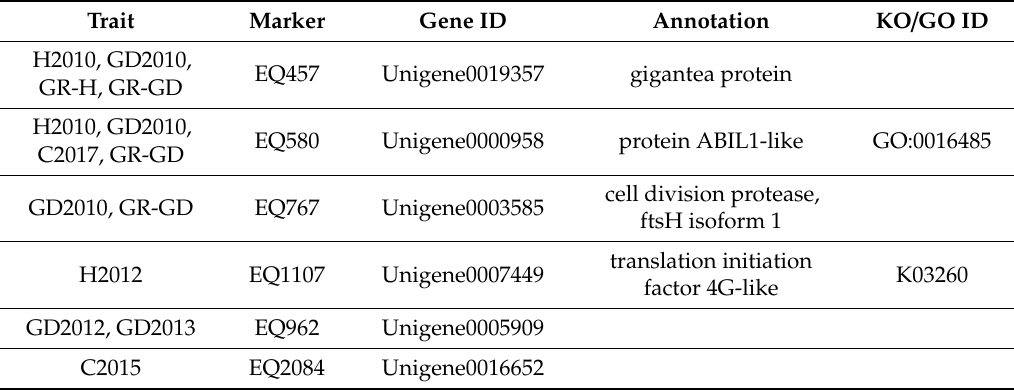
Table 5. Candidate QTL genes for growth traits in Eucommia ulmoides